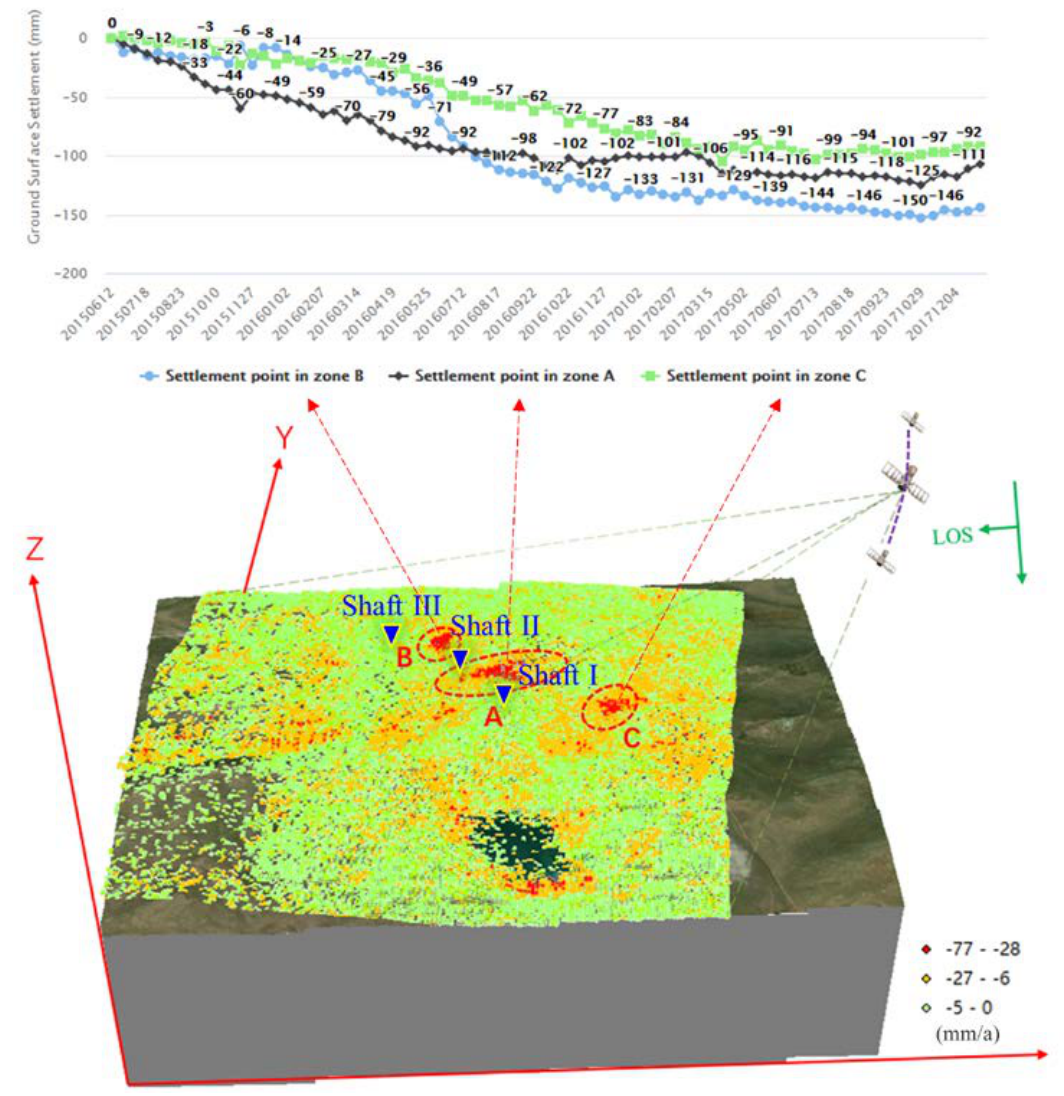
Figure 5. Subsidence-rate diagram of the mining area.